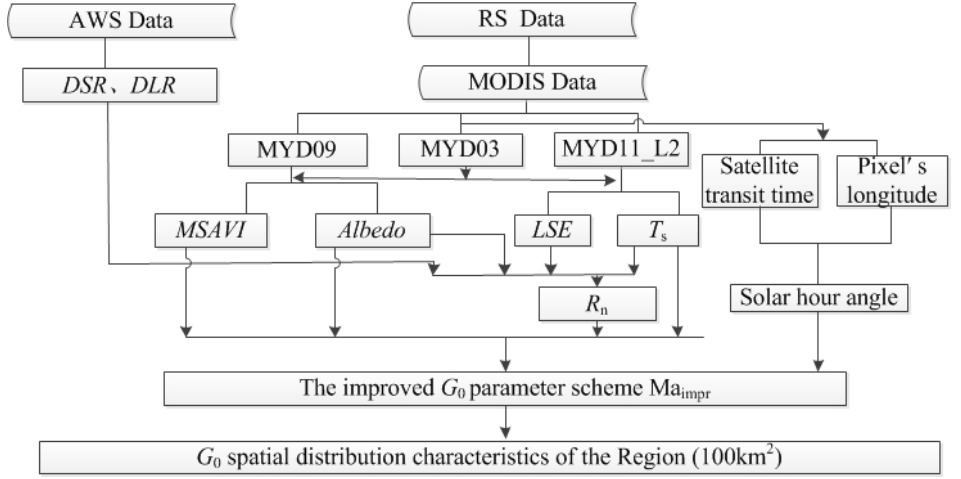
Figure 9. The inversion process of ground surface soil heat flux G 0 in the study area